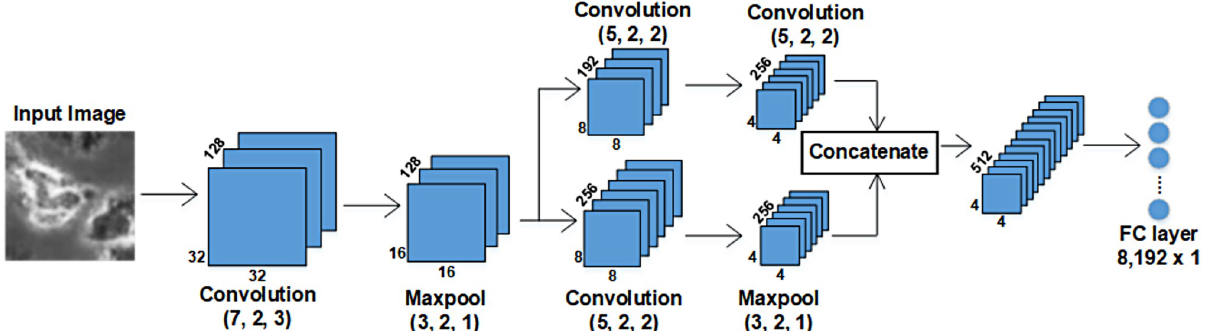
Fig 9. Architecture of Triplet CNN A and Triplet CNN B in Fig 8. The parameters within the parenthesis indicate the kernel dimension, stride and padding. By skipping intermediate layers and concatenating the feature maps of branched layers, DeephESC 2.0 is able to extract much more robust features, further improving the classification.